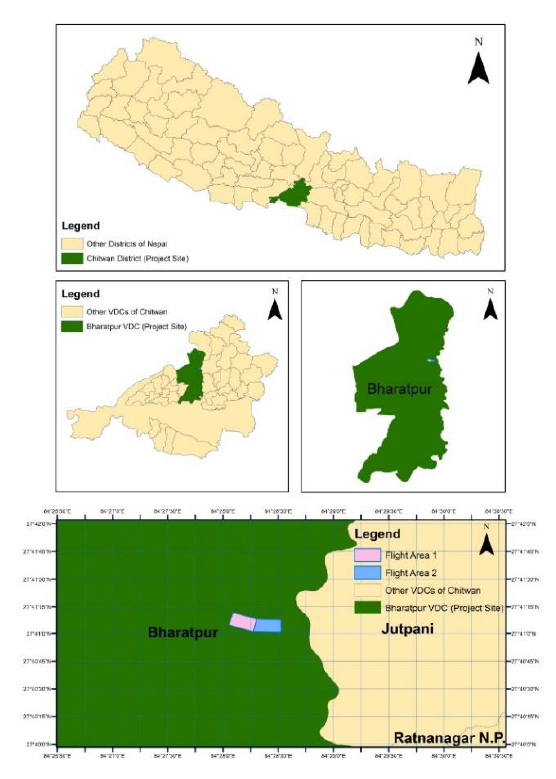
Figure 1. Location map of study area